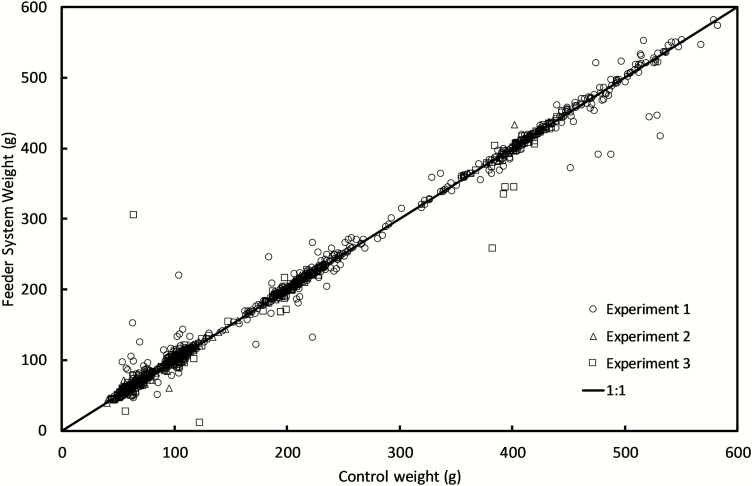
The relationship between the feeding system generated weight (g) and the weight measured on an external calibrated scale for experiments 1 (○), 2 (∆) and 3 (□). The diagonal line indicates the theoretical 1:1 relationship.